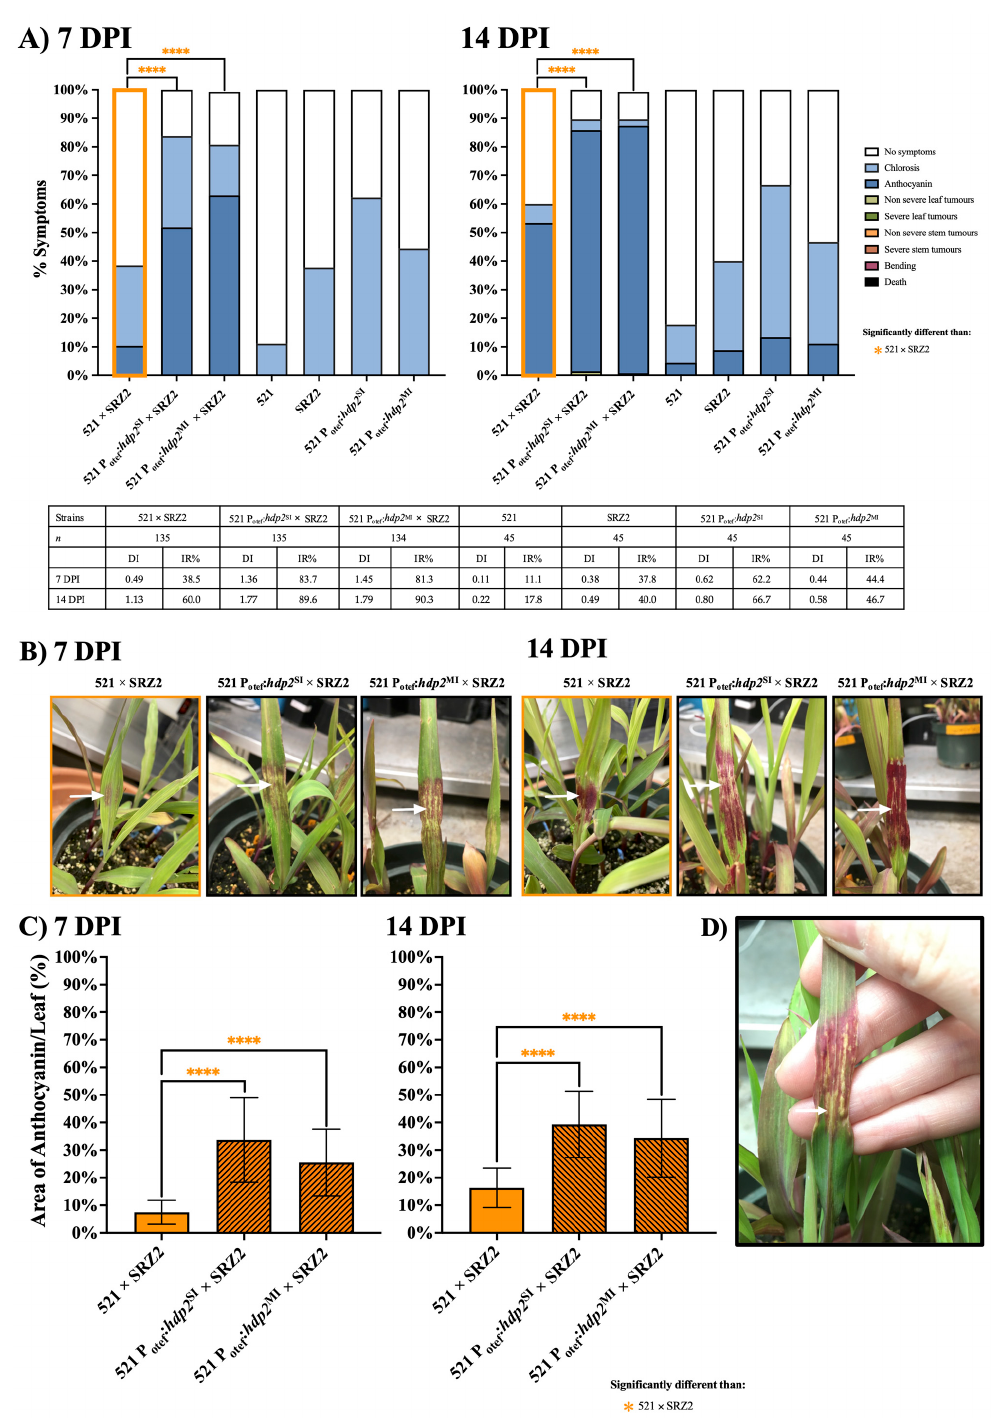
Figure 7. Hybrids constitutively expressing hdp2 induced greater anthocyanin than the unaltered hybrid at 7 and 14 DPI. ( A ) Colored bars represent the percentage of plants that developed a scored symptom. The table presents the number of plants infected ( n ), disease index (DI), and infection rate (IR). ( B ) Representative symptoms, indicated by the arrows, for 521 × SRZ2 infections is anthocyanin, for 521 P otef : hdp2 SI × SRZ2 infections are anthocyanin + chlorosis, and for 521 P otef : hdp2 MI × SRZ2 infections are anthocyanin + chlorosis. ( C ) The percent (%) of leaf surface area in which anthocyanin was induced was quantified using ImageJ software. Note: only six leaves were processed for 521 × SRZ2 at 7 DPI. Three separate experiments were conducted, and the combined results are presented. Statistical differences were calculated comparing the hybrid to each parental dikaryon (**** = p < 0.0001). ( D ) Leaf tumor formation, indicated by the arrow, induced by the 521 P otef : hdp2 SI × SRZ2 infection.